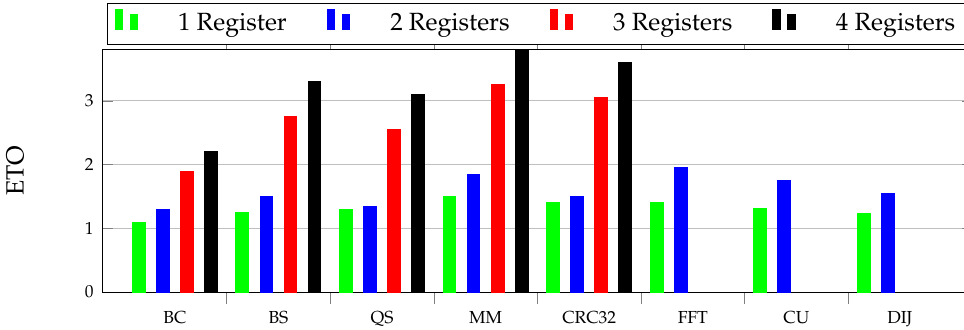
Figure 12. Measured execution time overhead for different case studies.